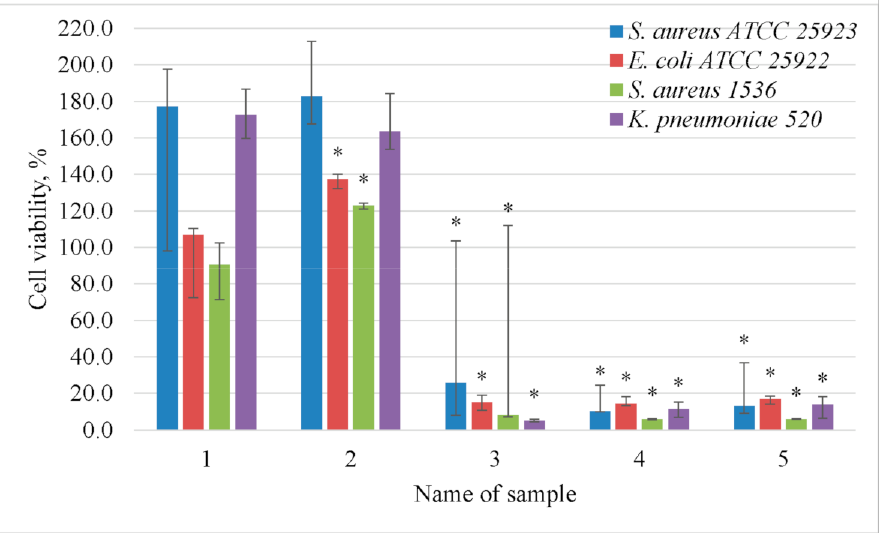
Figure 4. Bacterial cell survival after subculturing with supernatant by MTT test. The yeast extracts were obtained from samples of yeast S. cerevisiae 71B, cultured in 20% glucose solution with the addition of: (1) sterile dH 2 O, (2) 0.5 mM AgNO 3 , (3) 1.0 mM AgNO 3 , (4) 1.5 mM AgNO 3 and (5) 2.0 mM AgNO 3. * p <